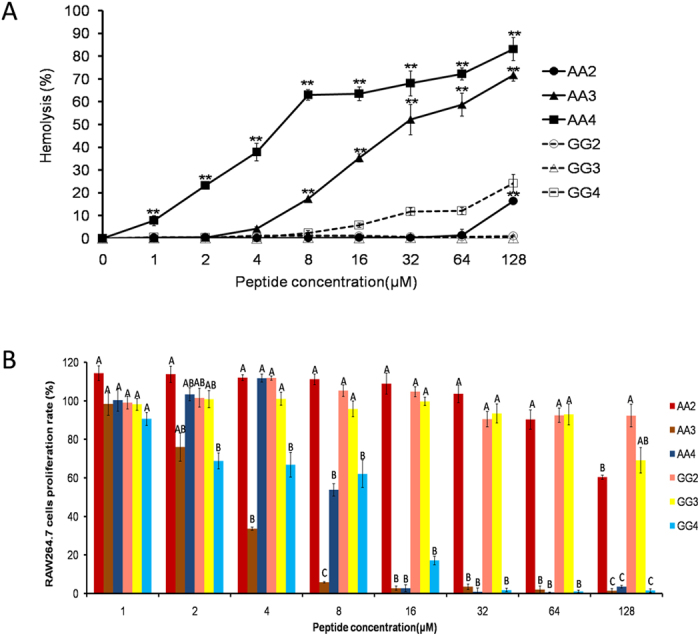
The security of the centrosymmetric peptides.(A) Hemolytic activity of the centrosymmetric peptides against hRBCs. (B) Cytotoxicity of the centrosymmetric peptides against RAW 264.7 cells. The graphs were derived from average values of three independent trials. P** < 0.01, compared to the values of GG2, GG3 and GG4, respectively at the same concentration. Means in the same concentration with different superscript are very significant difference (P < 0.01).